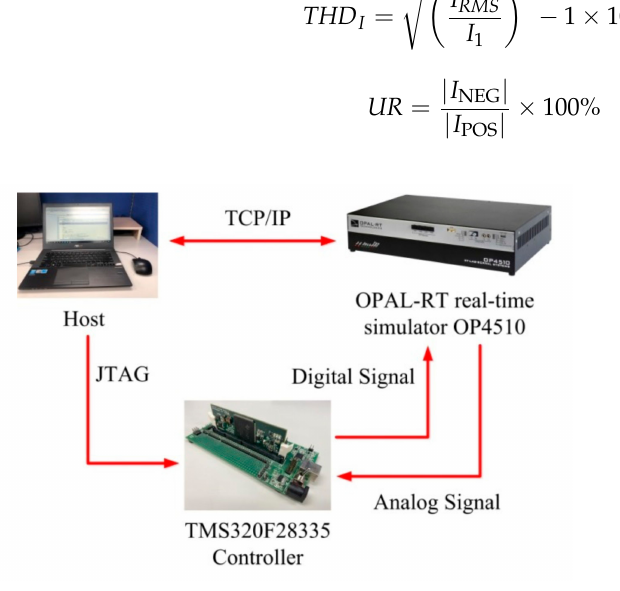
Figure 3. Experimental configuration with real-time simulator. Table 1. System parameters for